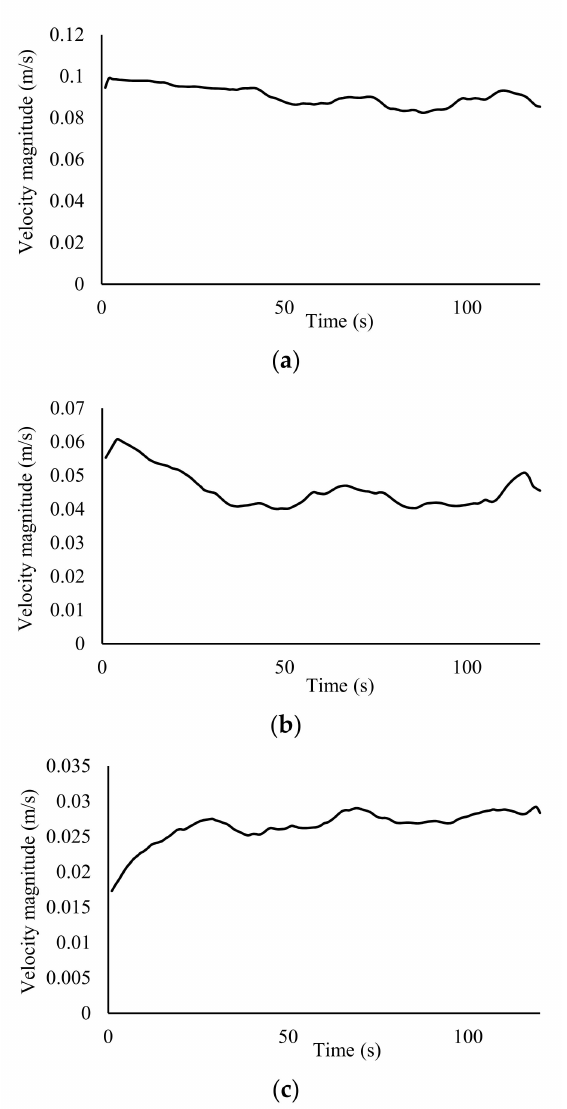
Figure 4. Time-series graphs for the velocity magnitude along the trajectory of the central jet in case C2 at ( a ) x/(D.F d ) = 0.4, ( b ) x/(D.F d ) = 0.75, and ( c ) x/(D.F d ) =